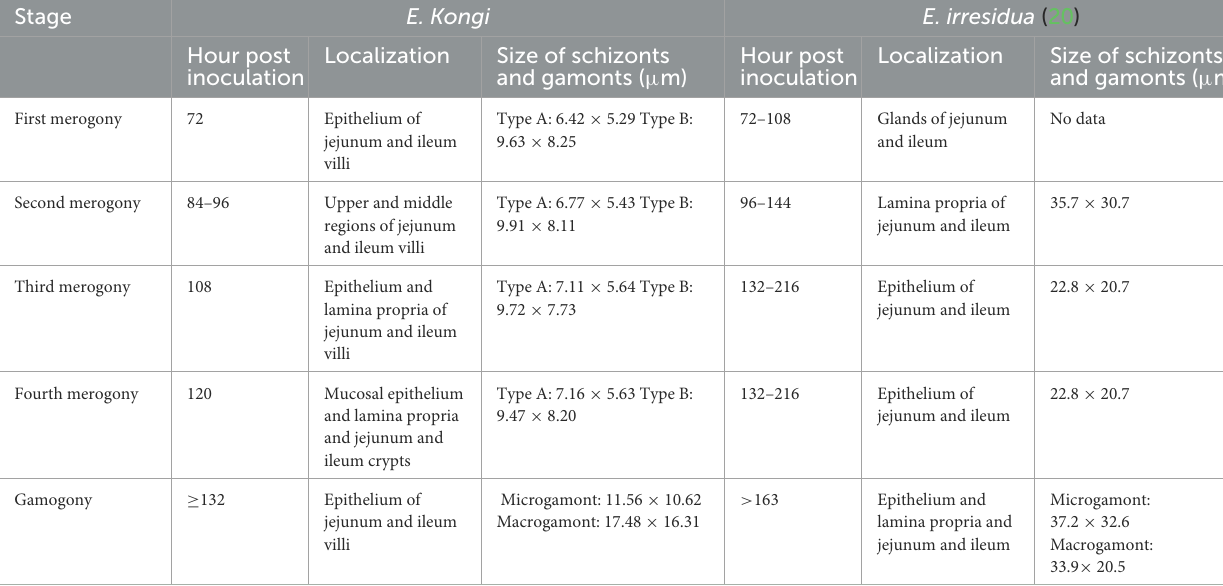
TABLE 4 A comparison of the endogenous development of E. kongi and E. irresidua .